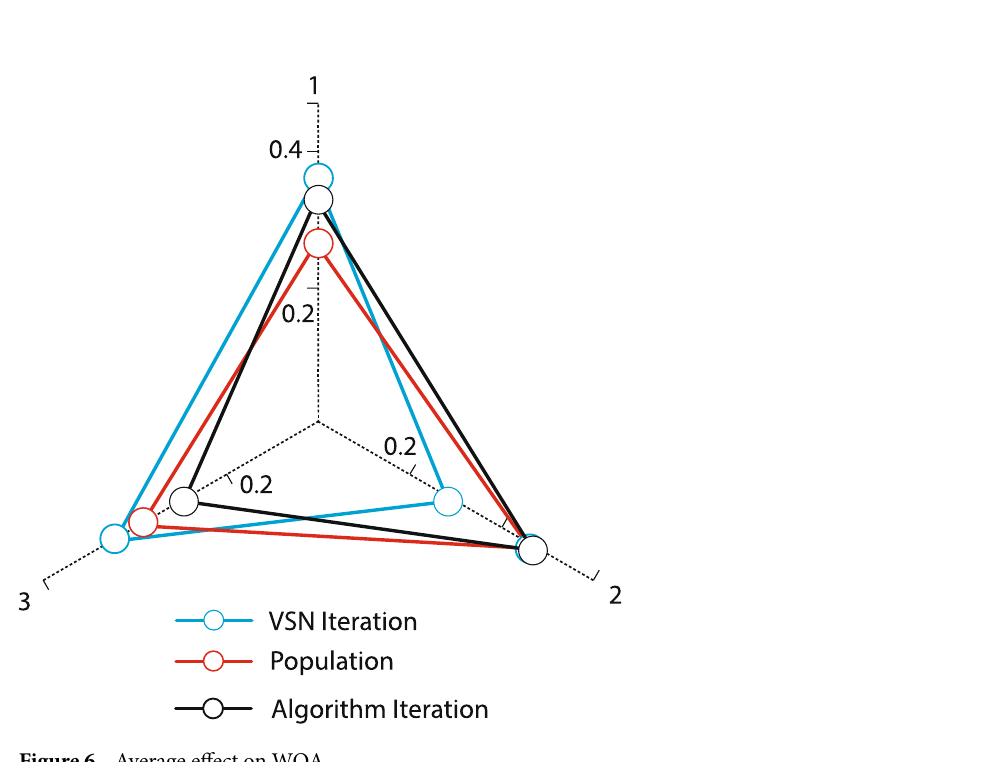
Figure 6. Average effect on